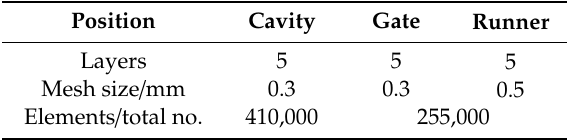
Table 1. Mesh settings and total amount of